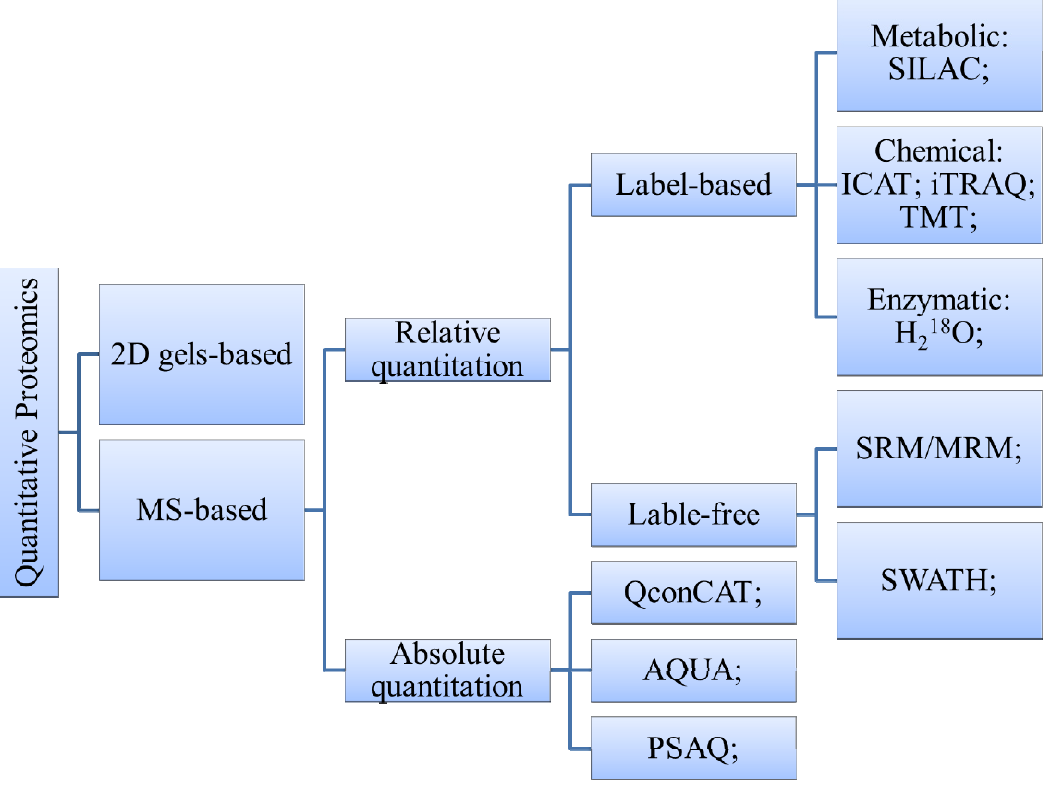
Figure 2. Overview of main quantitative proteomics methods [19]. 2D gels: Two-dimensional gel electrophoresis; MS: mass spectrometry; SILAC: Stable Isotope Labeling by Amino Acids in Cell Culture; ICAT: Isotope-Coded Affinity Tags; iTRAQ: isobaric Tag for Relative and Absolute Quantitation; TMT: Tandem Mass Tags; SRM/MRM: selected/multiple reaction monitoring; QconCAT: concatenated peptides; AQUA: Absolute Quantitation; PSAQ: Protein Standard Absolute Quantification; SWATH: Sequential Isolation